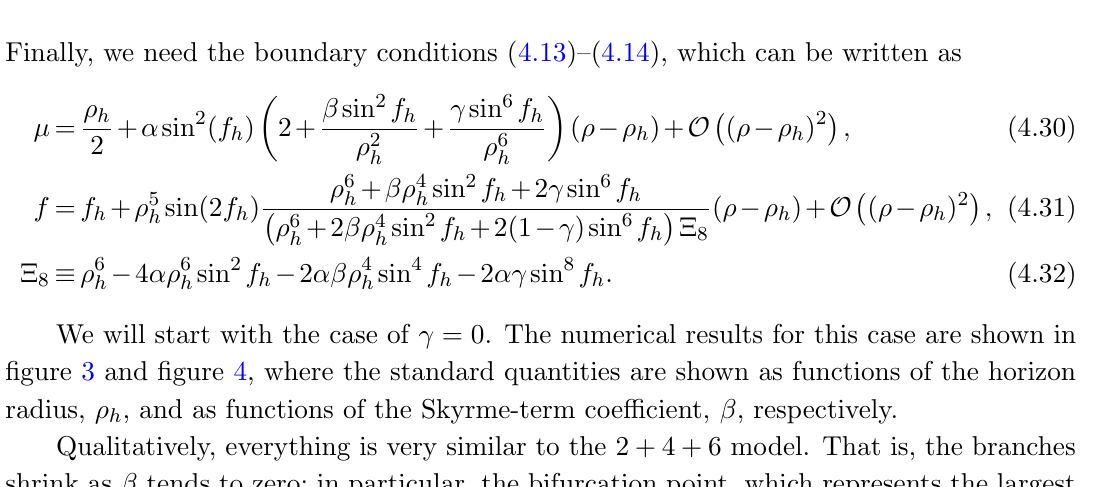
Figure 3 . Stable (black solid lines) and unstable (red dashed lines) branches of solutions in the 2 + 4 + 8 model with (cid:13) = 0: (a) the value of the pro(cid:12)le function at the horizon, f h ; (b) the derivative of the pro(cid:12)le function at the horizon, f (cid:26) ( (cid:26) h ); (c) the ADM mass, (cid:22) ( 1 ); (d) the Hawking temperature T H , all as functions of the size of the black hole, i.e. the horizon radius, (cid:26) h . The numbers on the (cid:12)gures indicate the di(cid:11)erent values of (cid:12) = 0 : 1 ; 0 : 2 ; : : : ;